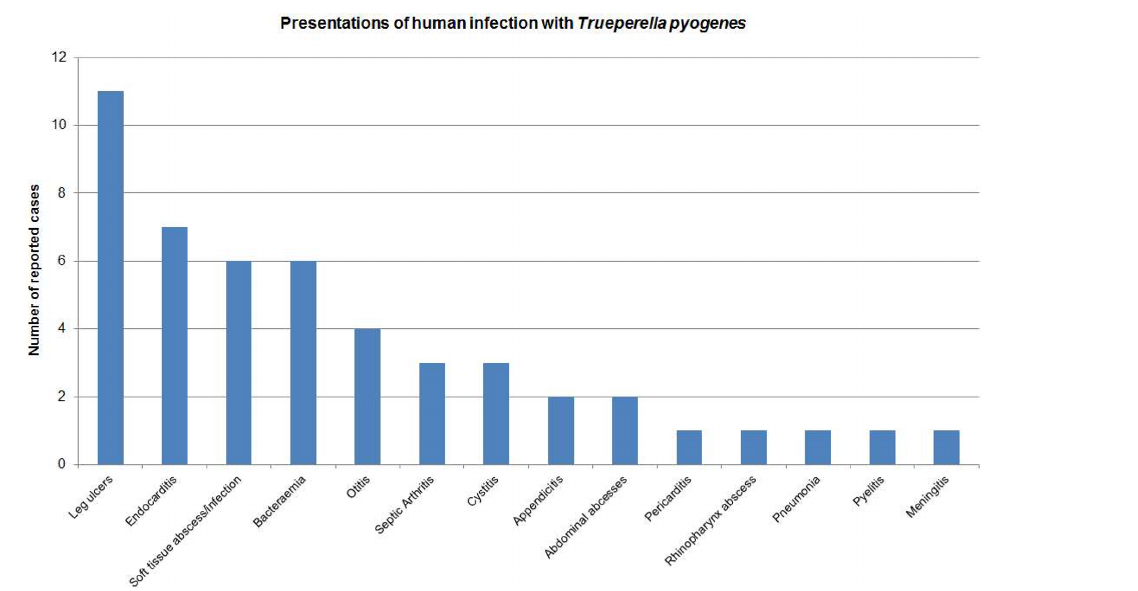
Figure 2. Results of a PubMed search using the terms “human”, “infection”, “ Trueperella pyogenes ”, “ Aranobacterium pyogenes ” and “ Actinomyces pyogenes ”. Forty-nine cases of human infection were